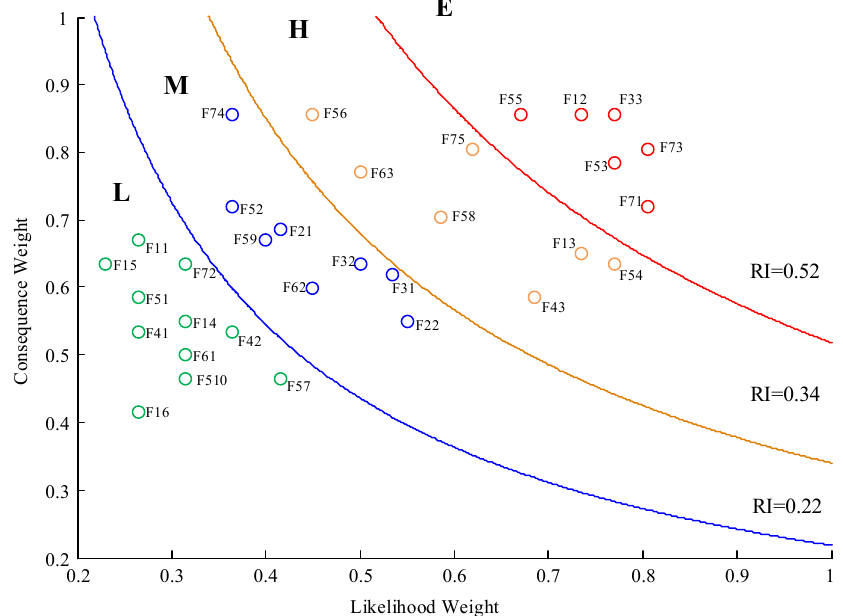
Figure 6. Two-dimensional risk matrix for risk factors in failure